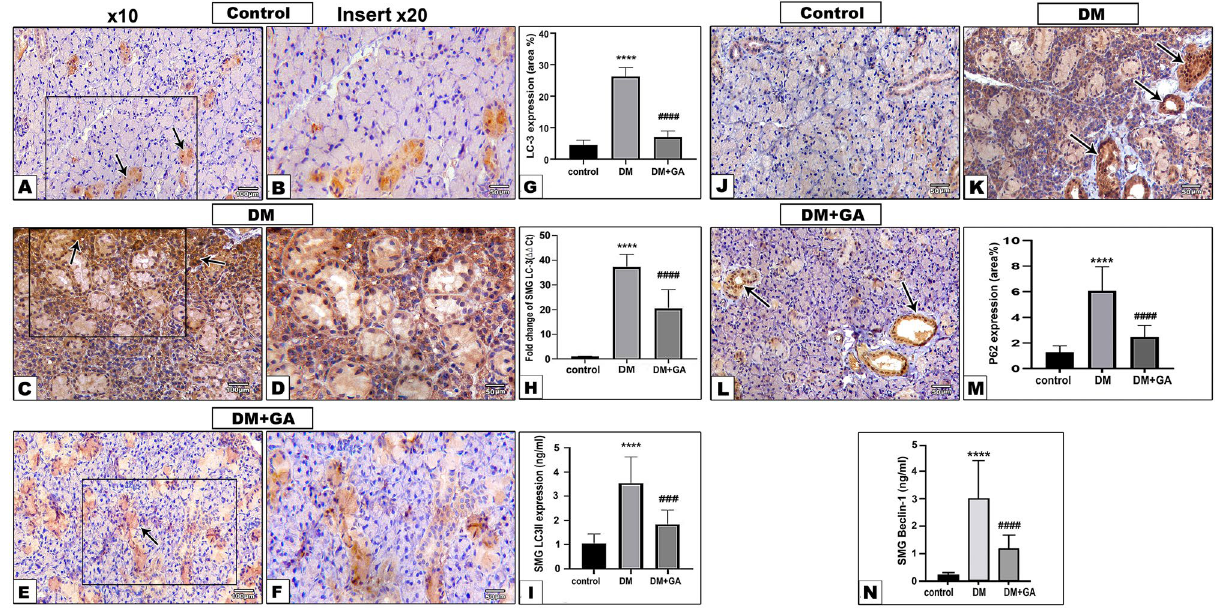
Figure 3. LC3 immunostained SMG sections showing positive nuclear and cytoplasmic reaction in intralobular ducts and GCD (arrows) in control group ( A , B ), while diabetic group showed strong positive cytoplasmic and nuclear reaction in both acini and ducts (arrows) ( C , D ). GA treated group ( E , F ) revealed a positive reaction in ducts only. (LC3, × 10, inserts × 20). Quantitative analysis of LC3 immunostaining (%area) ( G ) and fold change of LC3 gene expression ( H ). Quantitative analysis of ELISA results, LC3 II expression ( I ). Data were expressed as mean ± SE. P < 0.05 was considered significant. ****Significant compared to control group at P < 0.0001, ### Significant compared to diabetic group at P < 0.001and #### Significant compared to diabetic group at P < 0.0001. P62 immunostained SMG sections showing both cytoplasmic and nuclear positive reaction especially in the ducts in DM group ( K ). While, little mild cytoplasmic reaction and nuclear ductal reaction in both control ( J ) and GA group ( L ) (arrows) (P62 IHC, × 20). ( M ) Quantitative analysis of P62 immunostaining (%area). ( N ) Effect of GA treatment on Beclin-1expression. Data were expressed as mean ± SE. P < 0.05 was considered significant. ****Significant compared to control group at P < 0.0001, #### Significant compared to diabetic group at P <